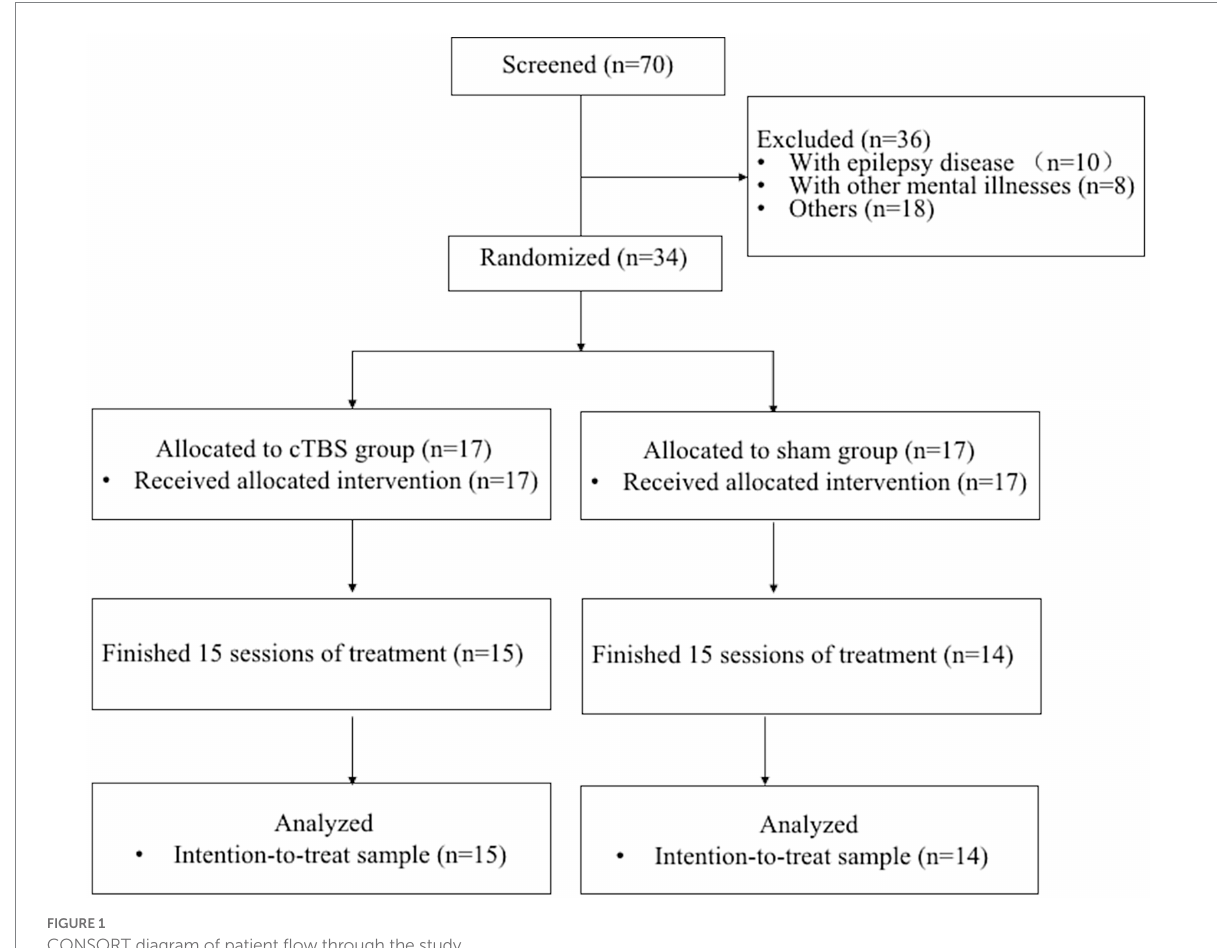
FIGURE 1 CONSORT diagram of patient flow through the